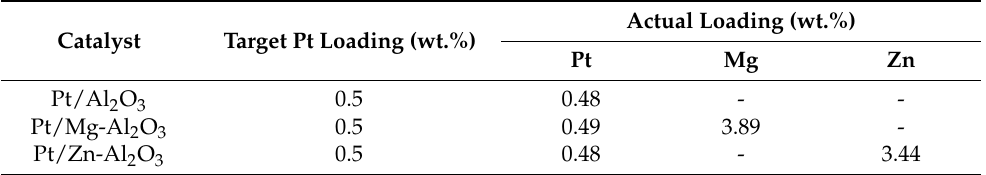
Table 2. Metal loadings and elemental composition of the catalysts determined using inductively coupled plasma-optical emission spectrometry (ICP-OES).